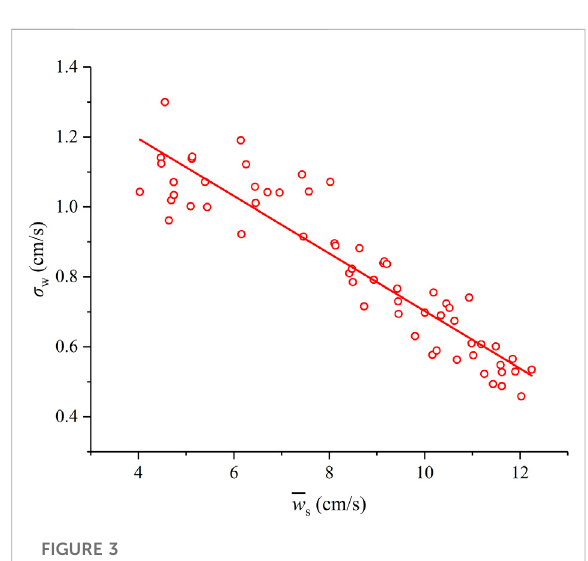
FIGURE 3 The correlation between time-average settling velocity and turbulent